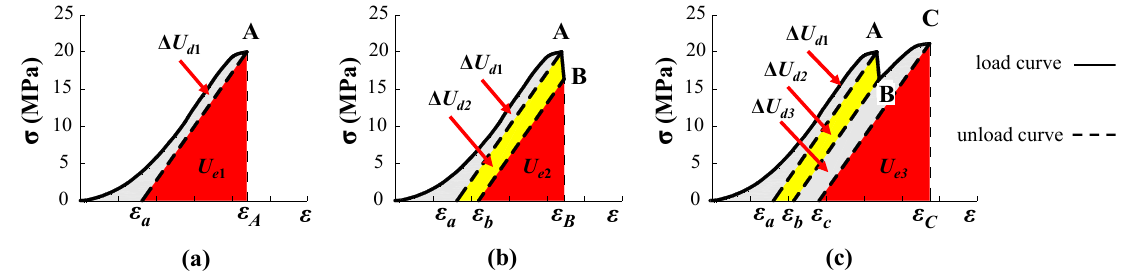
Figure 4. Illustrative graphs showing different energy states during pre-peak uniaxial compression: ( a ) pre-extreme stage (stage O-A); ( b ) stress drop stage (stage A-B); ( c ) stress re-rising stage (stage